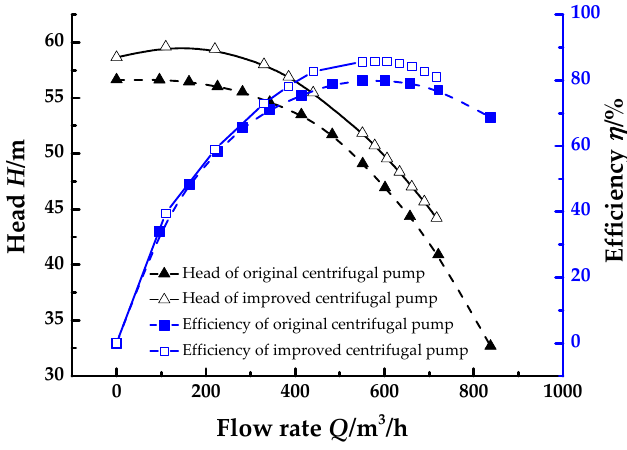
Figure 25. Hydraulic performance of improved and original centrifugal pump.